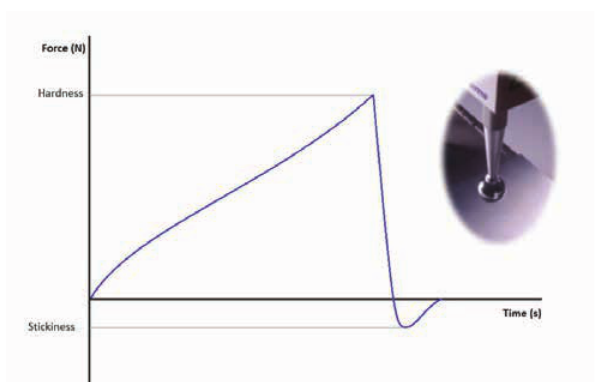
Figure 2: Example of a graph obtained with the puncture test using the P/2 probe